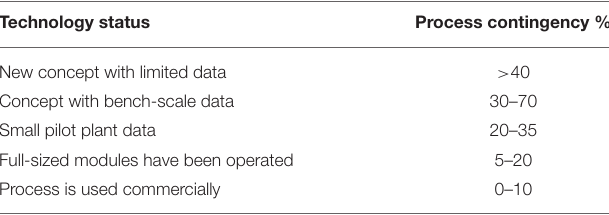
TABLE 3 | Guidelines for deriving process contingency (Electric Power Research Institute, 1993; AACE International, 2011; Rubin et al., 2015).